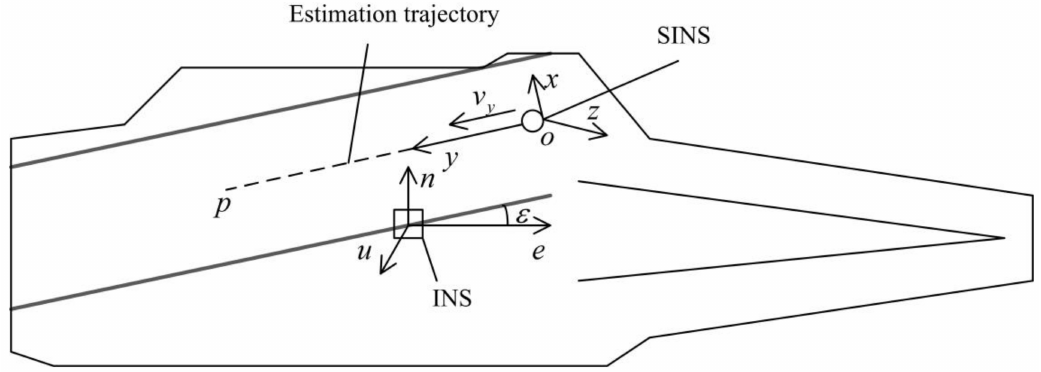
Figure 1. Principle diagram of dynamic inertial measurement